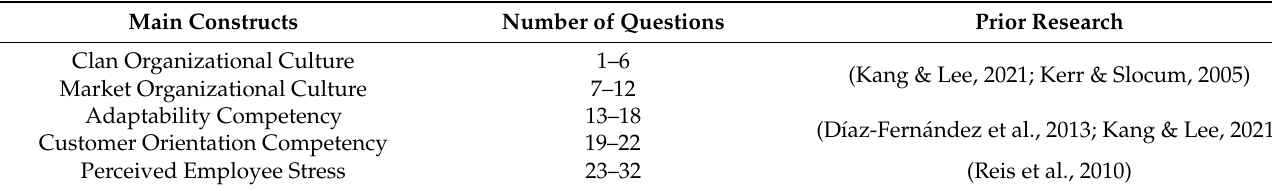
Table 1. Summarized Variable based on Previous Resources.